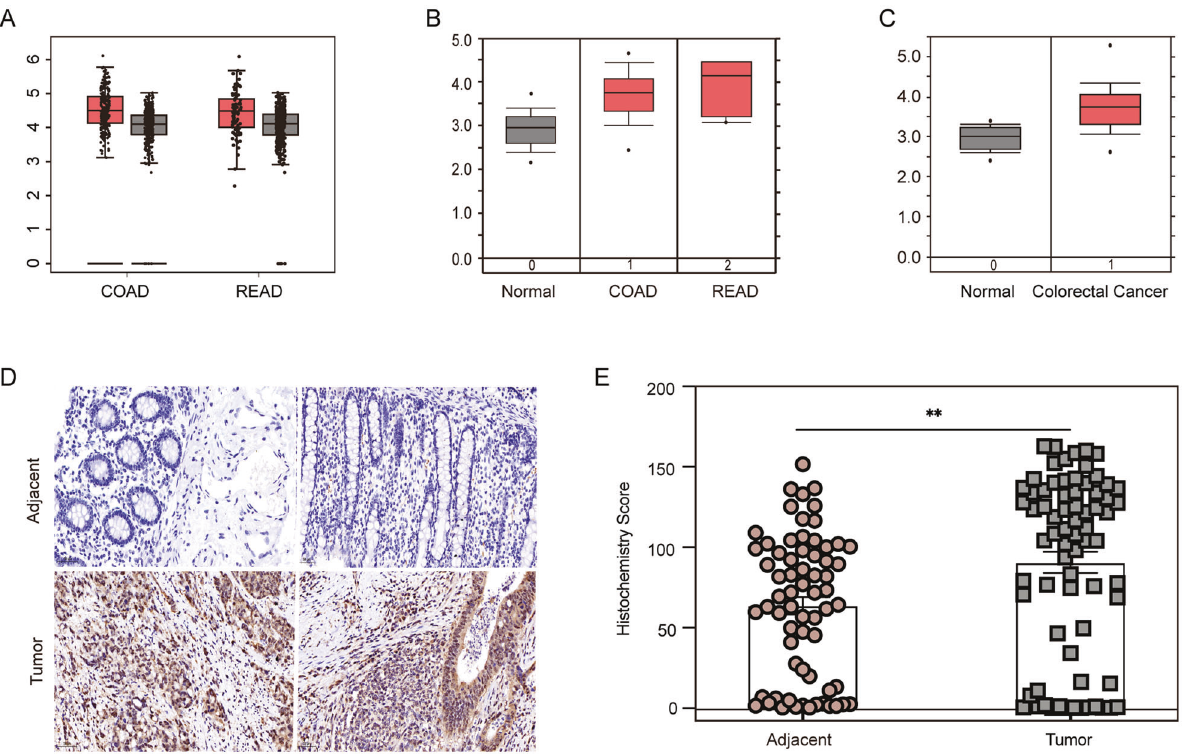
Fig. 1 USP14 is upregulated in colorectal cancer. A USP14 expression in colon and rectal cancer tissues (red) ( n = 275 and n = 92, respectively) compared with that in relative benign tissues (gray) ( n = 349 and n = 318, respectively) obtained from the GEPIA online tool. B , C Sabates-Bellver ( n = 32, n = 25 and n = 7) and Hong colorectal data ( n = 12 and n = 70) from the Oncomine database indicate USP14 mRNA levels in colorectal cancer patient tissues (red) compared with those in benign tissues (gray). D IHC staining for USP14 in colorectal cancer tissue microarrays containing adjacent tissues and normal tissues. E Analysis of USP14 expression in colorectal cancer tissue microarrays from 72 tumor and 66 adjacent tissues. COAD, colon adenocarcinoma; READ, rectal adenocarcinoma. The data are presented as the means ± SEM. Statistical signi fi cance was analyzed by Student ’ s t test. ** p <